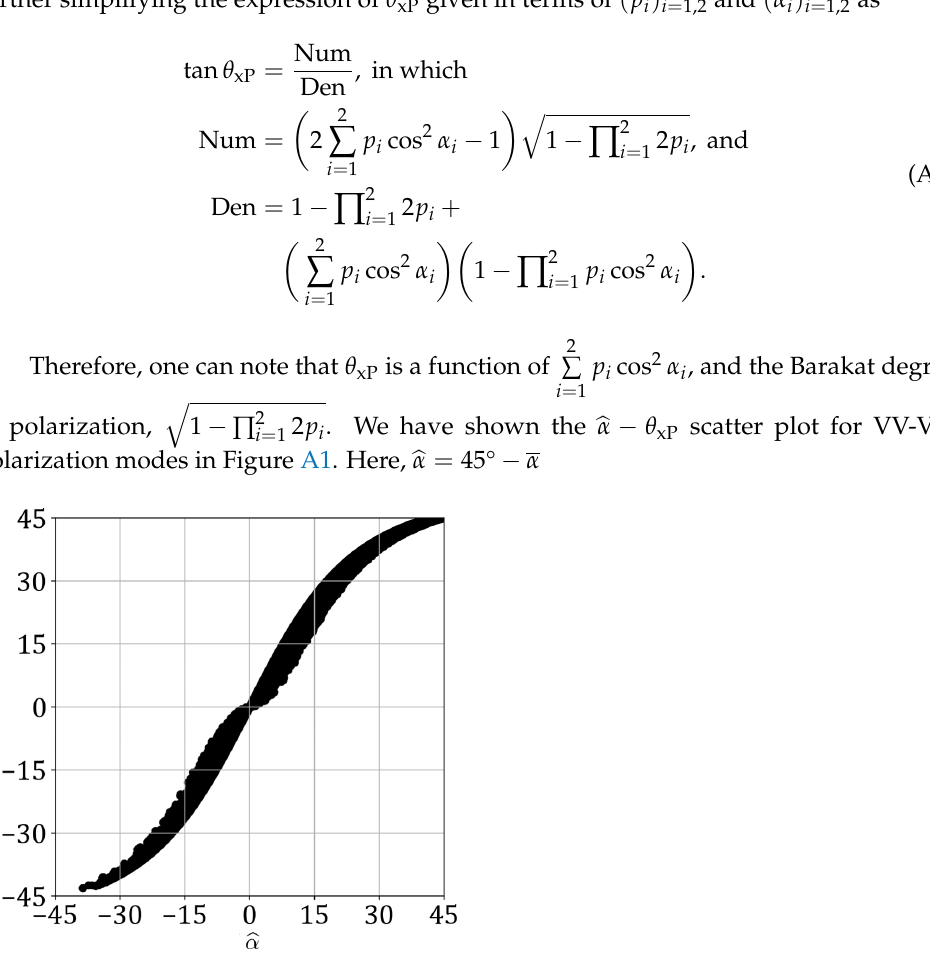
Figure A1. (cid:98) α − θ xP plot for RADARSAT-2 data over San Francisco in VV-VH mode.